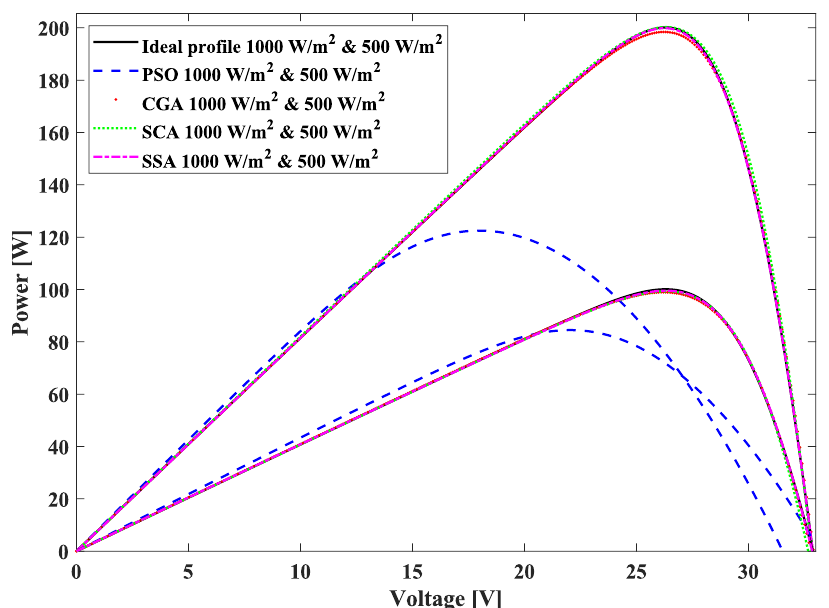
Figure 4. Simulation performed with the parameters found for the lowest errors in the KC200GT PV panel under irradiance levels of 1000 W/m 2 and 500 W/m 2 .